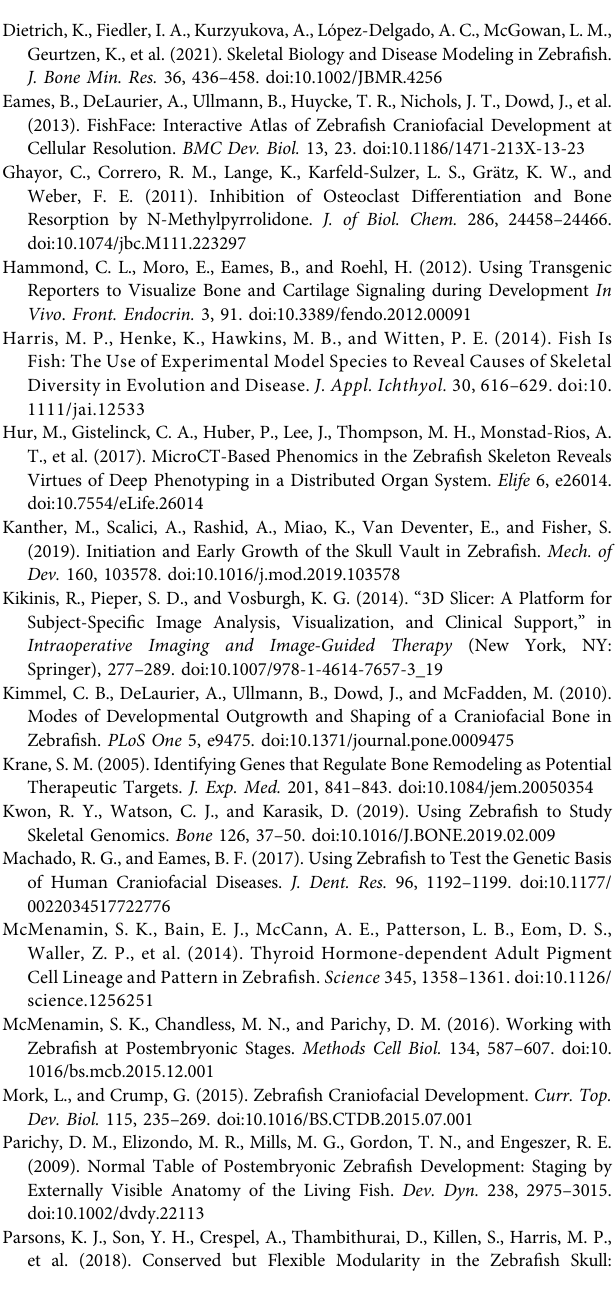
Supplementary Figure 7 | Interactive PDF of 3D model of 20 mm SL zebra fi sh whole head (top) and whole body (bottom) scans. Supplementary Figure 8 | Interactive PDF of 3D model of 24 mm SL zebra fi sh whole head (top) and whole body (bottom) scans. Supplementary Video 1 | Density scans of the whole zebra fi sh skeleton ranging from 12 mm to 25 mm SL. Supplementary Video 2 | Colored density scans of zebra fi sh craniofacial skeleton ranging from 12 mm to 25 mm SL. Warmer colors indicate higher density regions. Supplementary Table 1 | Information about every individual scanned. Note that smaller individuals could not be accurately sexed. For individual scans available on MorphoSource, the ID is given in the last